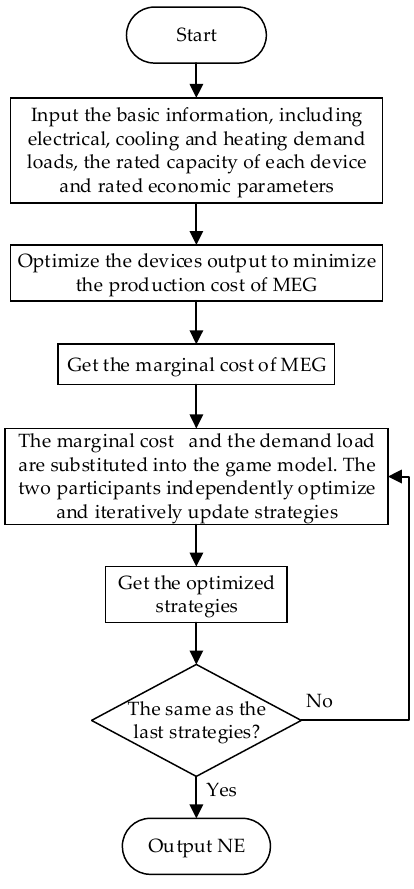
Figure 3. Flow chart of solving the leader-follower game.